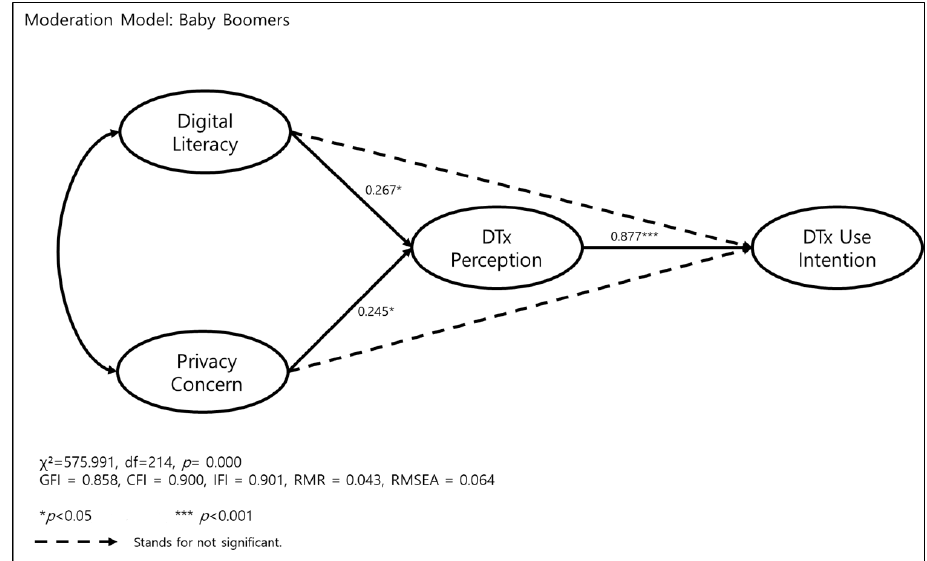
Figure 2. Effect of digital literacy and privacy concern on digital therapeutics perception and digital therapeutics (DTx) use intention in baby boomers.